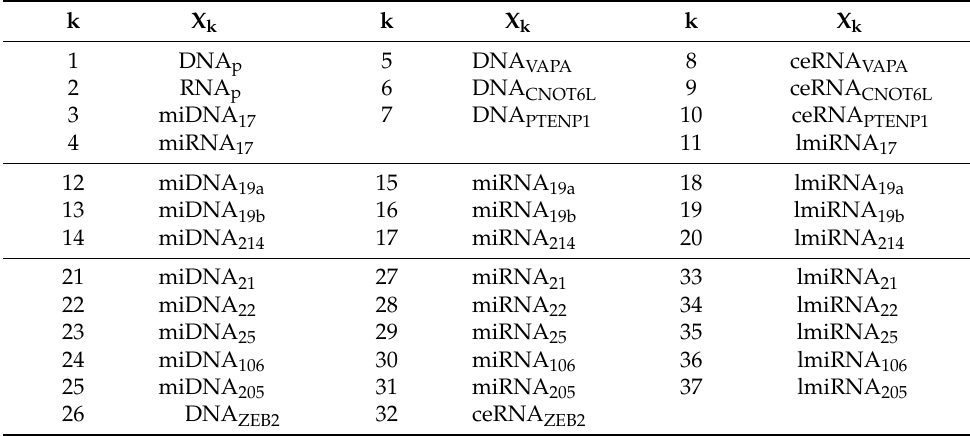
Table 2. X-species involved in the chemical reactions